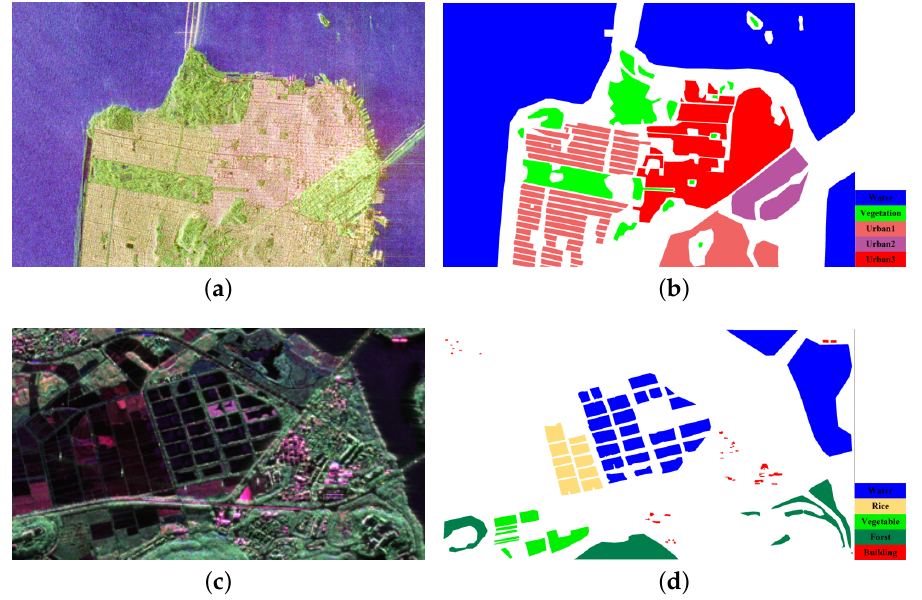
Figure 3. The real PolSAR images and the corresponding ground-truth maps. ( a ) Pseudocolor image of San Francisco region. ( b ) Ground-truth map of ( a ) (5 classes). ( c ) Pseudocolor image of Boao region. ( d ) Ground-truth map of ( c ) (5